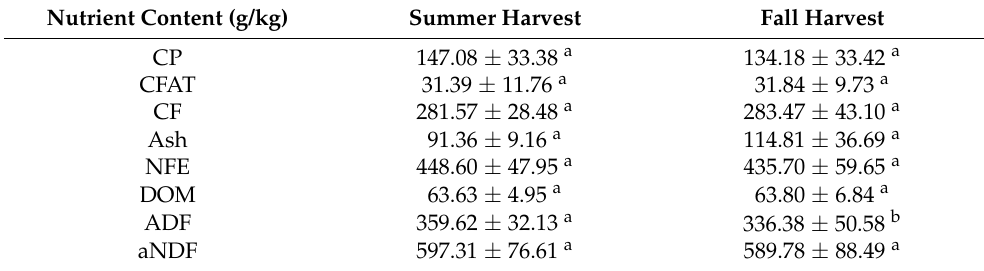
Table 8. Nutrient levels according to the harvest date (g/kg of dry matter).